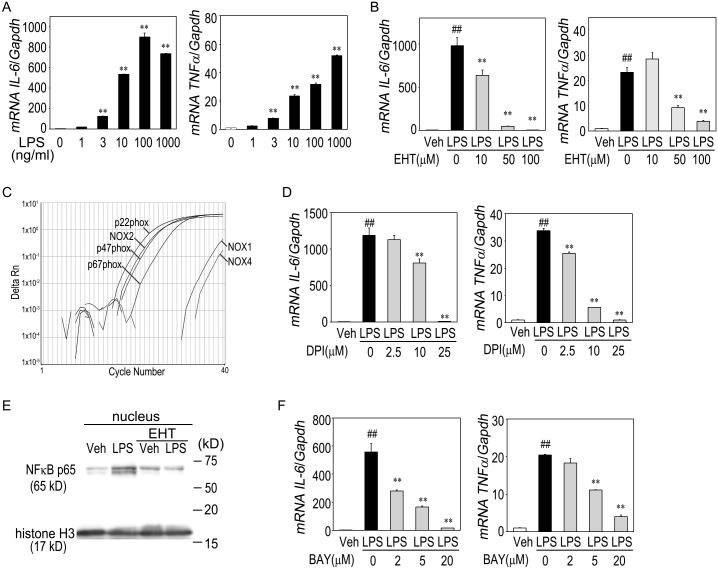
LPS-triggered cytokine mRNA induction and its underlying mechanisms in cultured macrophages.(A) Dose dependency of IL-6 and TNFα mRNA induction in response to LPS (1, 3, 10, 100, and 1000 ng/ml) for 3 h in the cultured macrophage cell line RAW264.7. Data are means ± s.e.m. Statistical analysis was performed by one-way ANOVA. **P < 0.01 vs. Vehicle. n = 4 per each group. (B) Effects of pretreatment with the Rac1 inhibitor EHT1864 (10, 50, and 100 μM) on LPS (100 ng/ml)-evoked mRNA induction of IL-6 and TNFα. Statistical analysis was performed by one-way ANOVA. ##P < 0.01 vs. Vehicle; **P < 0.01 vs. LPS without inhibitors. n = 4 per group. (C) The mRNA expression of NADPH oxidase components, NOX1, NOX2, NOX4, p22phox, p47phox, and p67phox, in cultured macrophage RAW264.7. (D) Effects of preincubation with the NADPH oxidase inhibitor diphenyleneiodonium (DPI: 2.5, 10, and 25 μM). Statistical analysis was performed by one-way ANOVA. ##P < 0.01 vs. Vehicle; **P < 0.01 vs. LPS without inhibitors. n = 4 per group. (E) Representative immunoblots of NF-κB p65 in the nuclear fraction. Histone H3 was used as a loading control. (F) Effects of preincubation with the NF-κB inhibitor BAY11-7082 (2, 5, and 20 μM). Statistical analysis was performed by one-way ANOVA. ##P < 0.01 vs. Vehicle; **P < 0.01 vs. LPS without inhibitors. n = 4 per group.